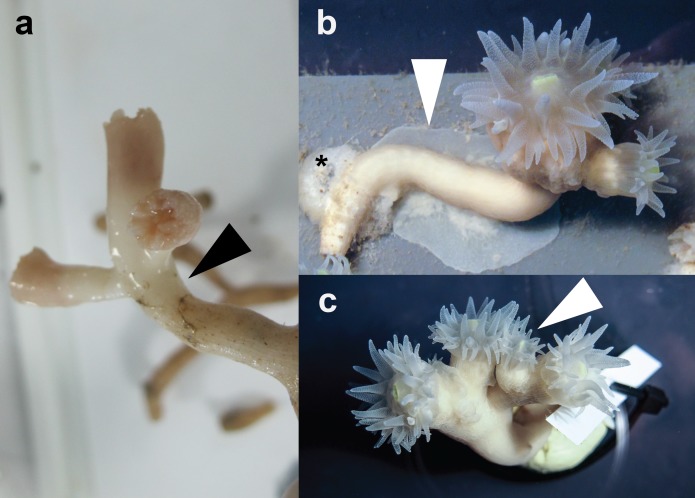
Specimens of E. fistula.(A) Freshly collected Eguchipsammia fistula specimen (arrowhead indicates tissue border). (B) Tissue overgrowing PVC substrate in long-term reared E. fistula (arrowhead indicates tissue; black asterix indicates aquaria glue). (C) Polyp proliferation in long-term reared E. fistula (arrowhead indicates newly grown polyp).